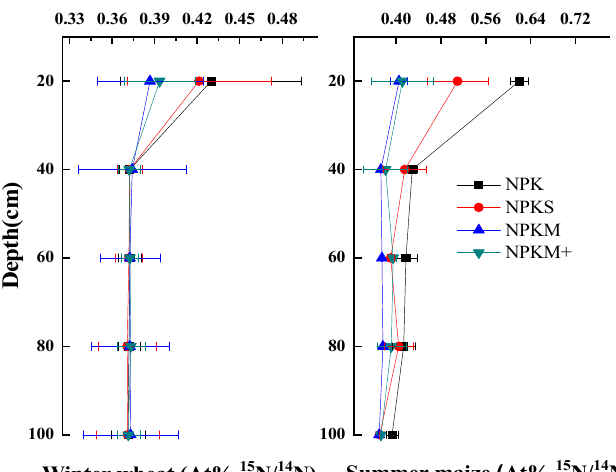
Figure 5. Distribution of at % 15 N/ 14 N along the 0–100 cm soil profile under different fertilization treatments in winter wheat and summer maize.